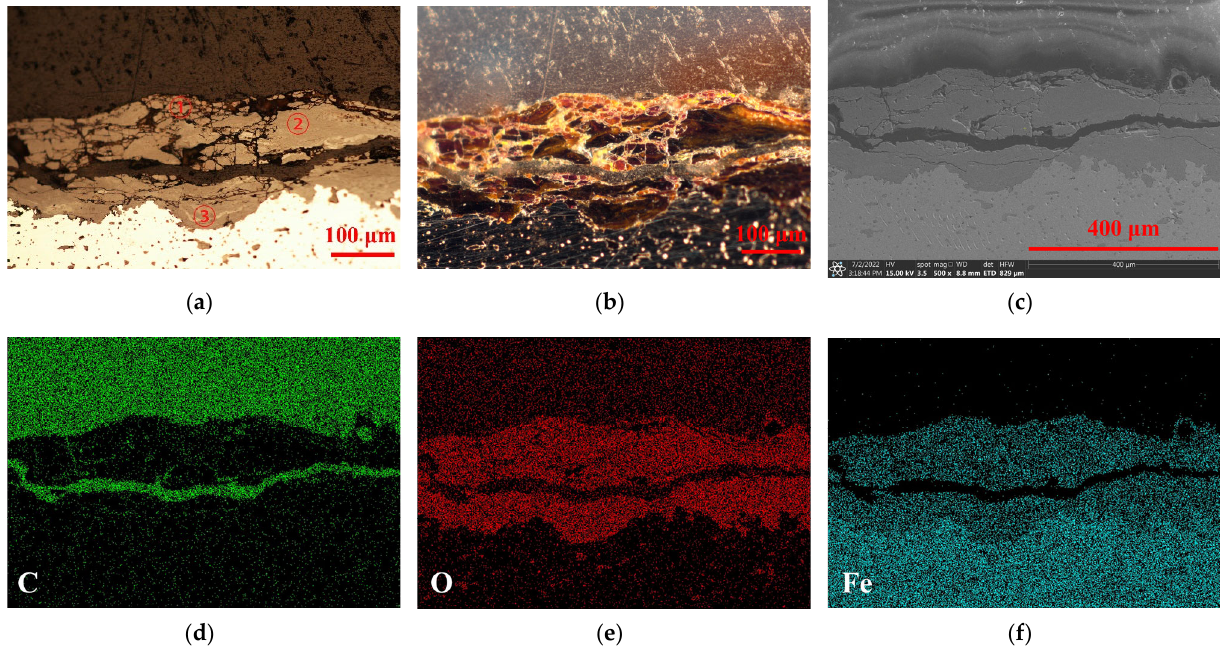
Figure 4. Original rust layer at area B. Optical microscopy in bright field ( a ); Optical microscopy in dark field ( b ); SEM picture ( c ); EDS of C, O, Fe elements ( d – f ).